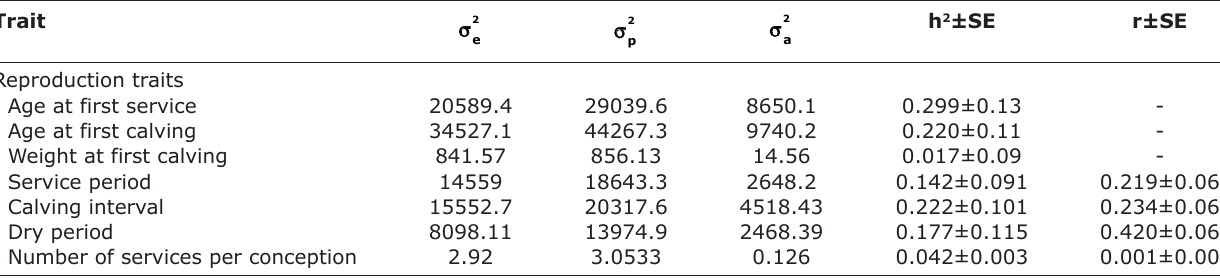
Table-3: Estimates of (co) variance components and genetic parameters for pooled lactation traits in Jersey×Red Sindhi crossbred cows.